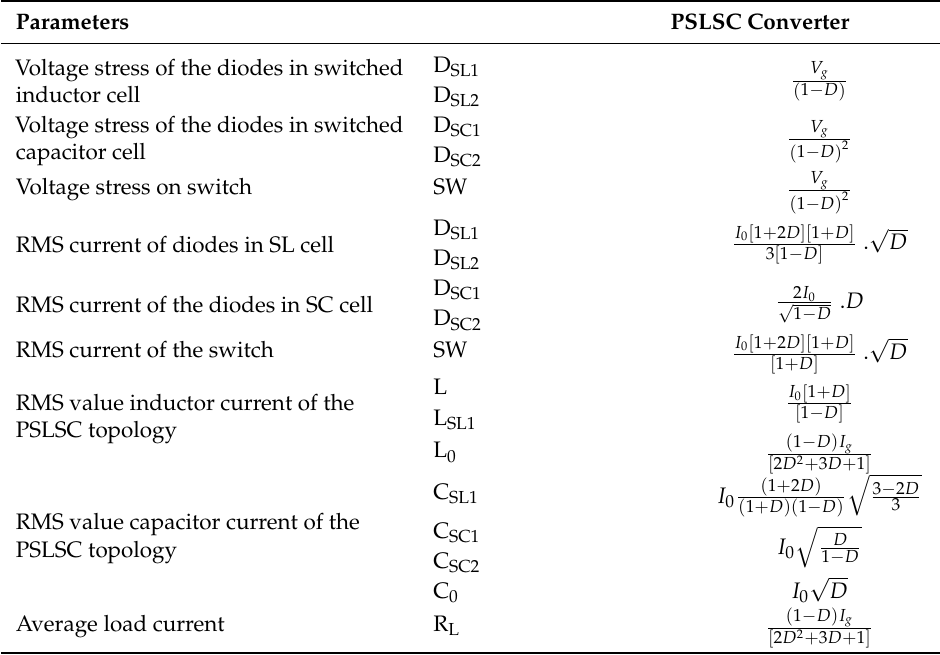
Table 4. Switch stresses of PSLSC